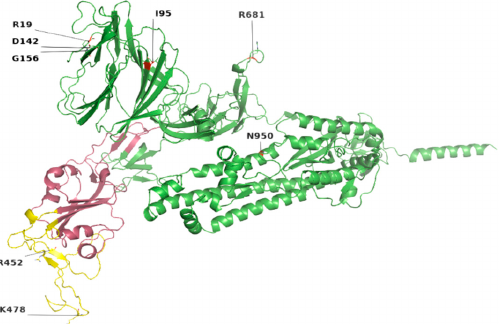
Figure 2. Location of most common mutations in S protein. Yellow indicates the receptor-binding motif, present in the RBD region (raspberry color). The majority of these mutations were found in the loop regions.